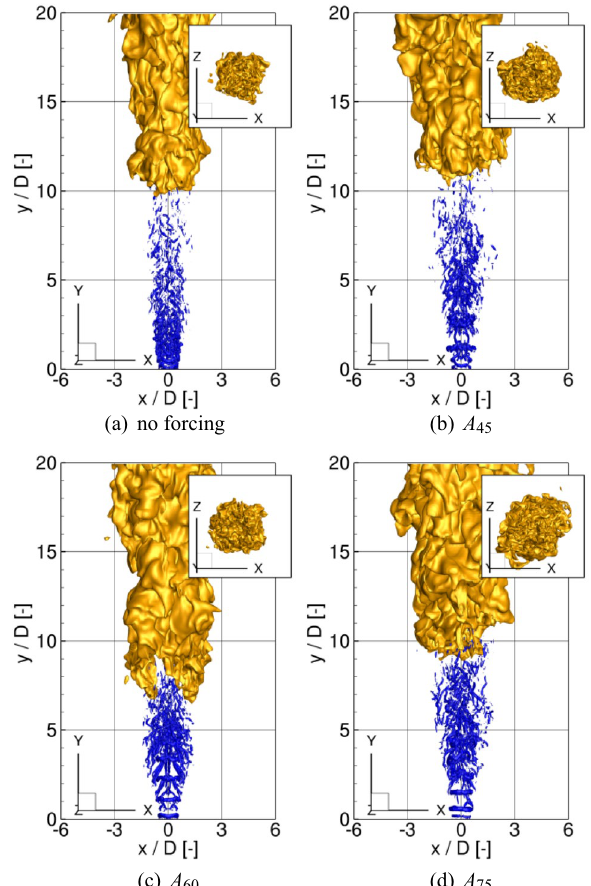
2 10s , blue) and temperature T − =